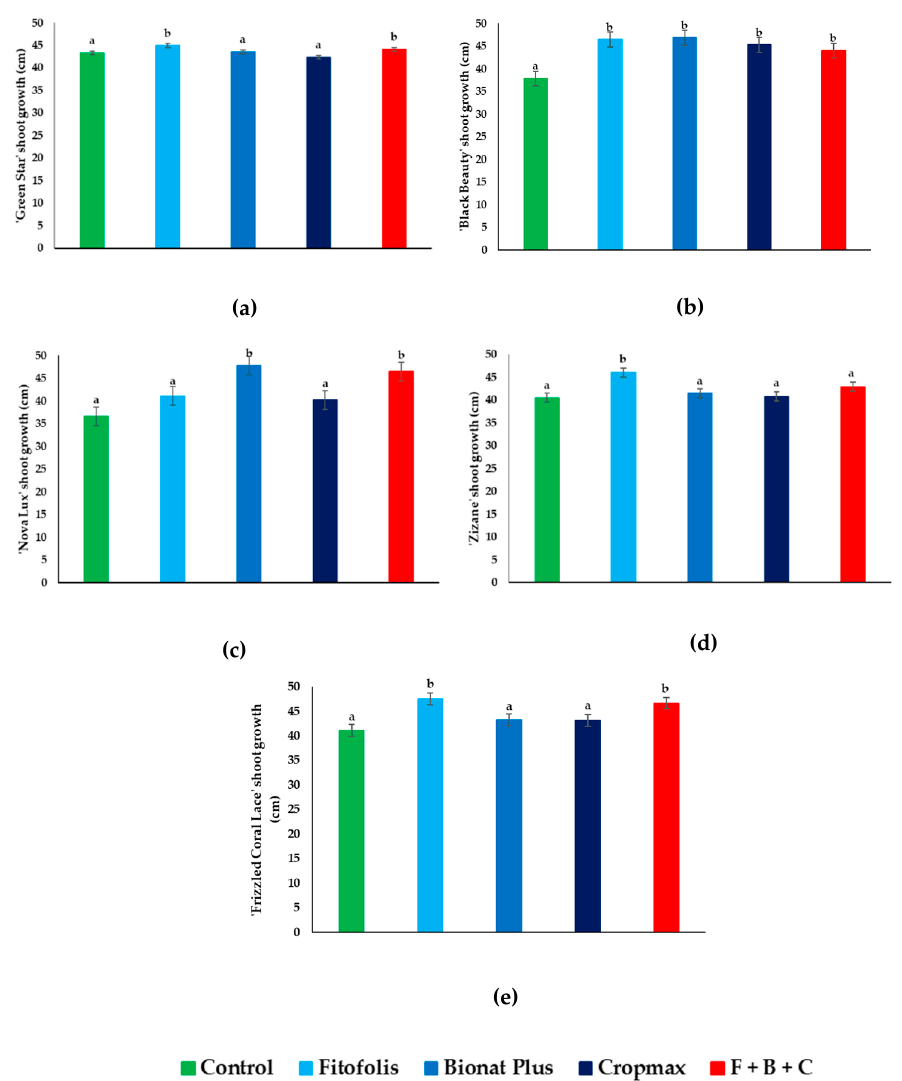
Figure 1. Effect of foliar fertilization on the shoot growth parameters in Gladiolus varieties: ‘Green Star’ ( a ), ‘Black Beauty’ ( b ), ‘Nova Lux’ ( c ), ‘Zizane’ ( d ), and ‘Frizzled Coral Lace’ ( e ). Plants shoot growth under control conditions, in the presence of the indicated foliar fertilization: Fitofolis, Bionat Plus, Cropmax and the mixture of Fitofolis–Bionat Plus–Cropmax (F + B + C). Shoot growth was measured in all plants just before starting the treatments (13 May), and before the harvesting of the inflorescences (9 August). Bars represent the means ± SE ( n = 10). Different letters above the bars indicate significant differences between the treatments, according to Tukey test ( α = 0.05).